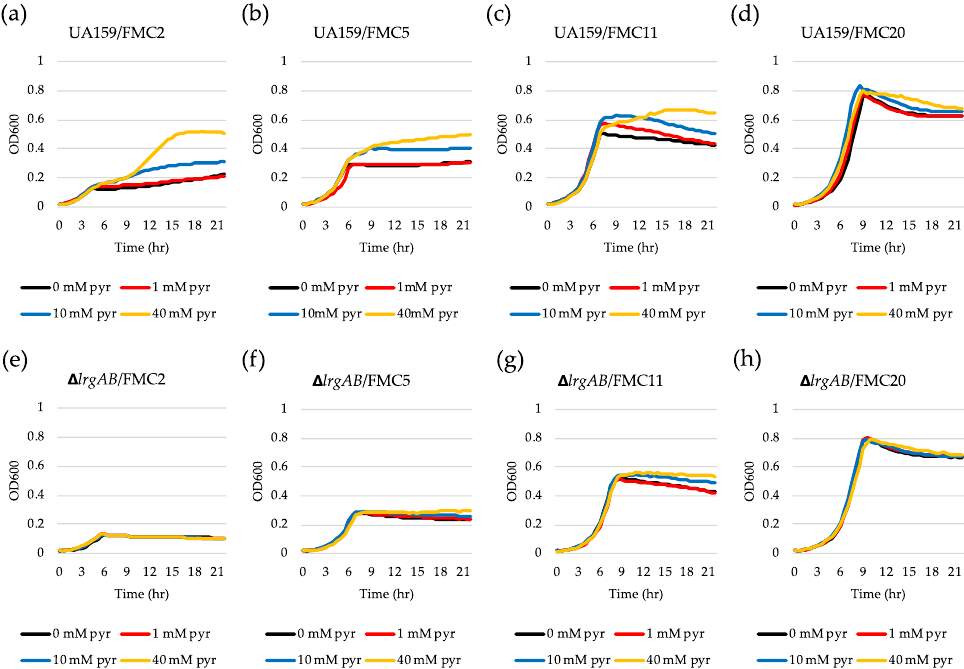
Figure 3. The e ff ect of exogenously added pyruvate on the stationary phase of growth of S. mutans UA159 wild type and ∆ lrgAB mutant strains. Wild type ( a – d ) and ∆ lrgAB ( e – h ) strains were grown in FMC2 (a and e), FMC5 (b and f), FMC11 (c and g) and FMC20 (d and h), supplemented by di ff erent concentrations of pyruvate (0, 1, 10 and 40 mM). Optical density at 600 nm was monitored every 30 min at 37 ◦ C using the Bioscreen C lab system. The results are representative of three independent experiments.